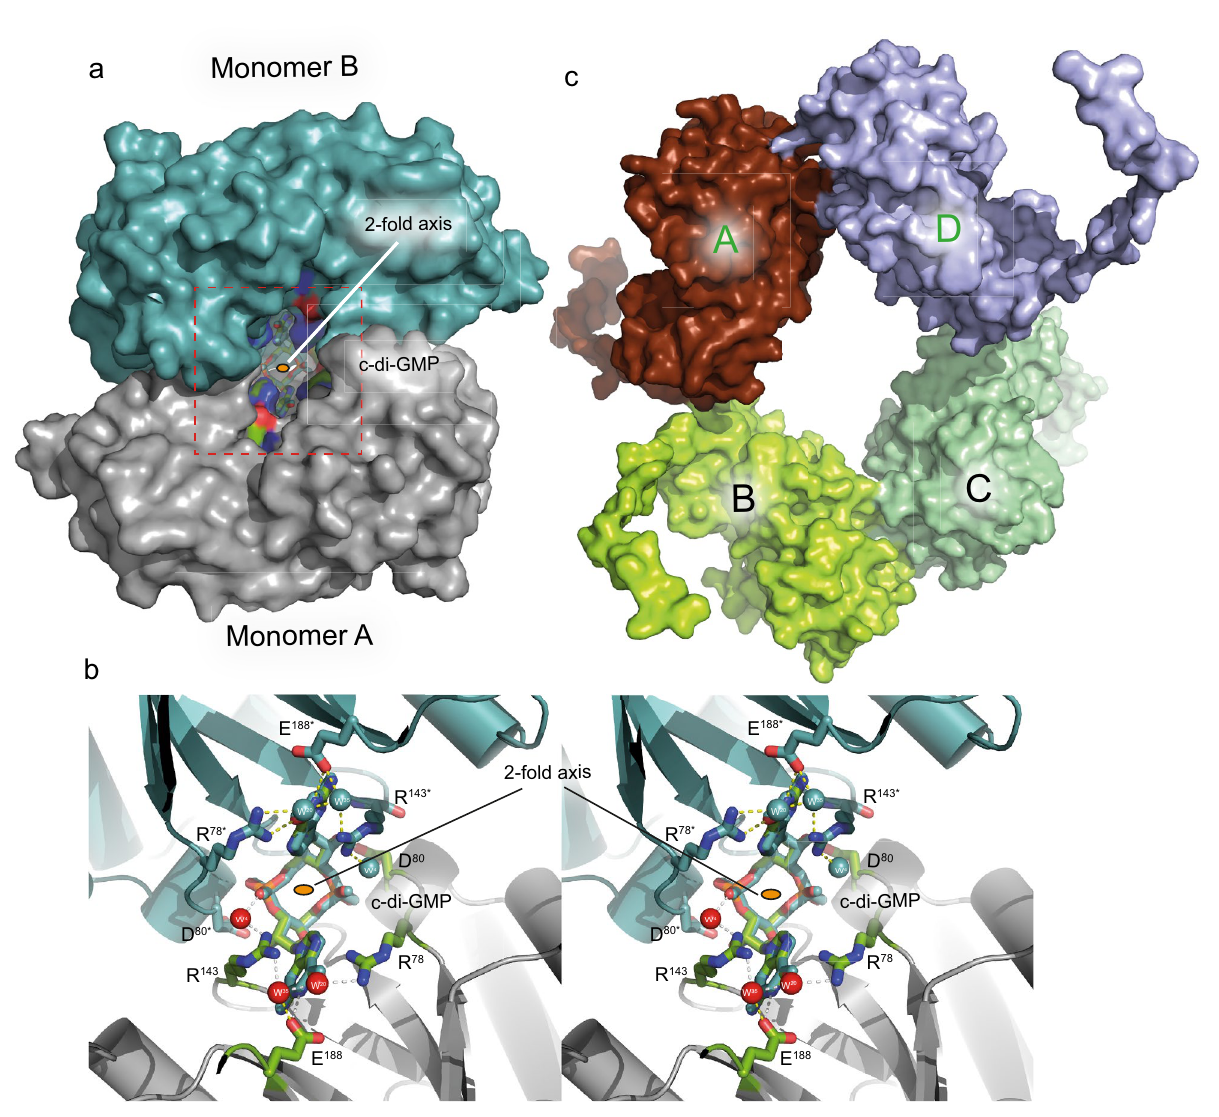
Figure 2. Crystal structures of SmbA Δloop with c-di-GMP bound across the crystallographic dyad and of apo SmbA Δloop . ( a ) The two monomers are depicted as surface (negatively charged atoms in red, positively charged atoms in blue and carbon atoms in green) with monomer A (gray) in standard orientation and monomer B (symmetry mate) in cyan. c-di-GMP in the dimer interface is shown as ball-and-stick model. ( b ) Stereoview down the twofold axis (indicated as a small orange ellipsoid), showing c-di-GMP forming isologous interactions with the two SmbA Δloop protomers. Relevant residues are shown as color-coded sticks (oxygen, red; nitrogen, blue; carbon, green or cyan and waters as red and cyan spheres) and labeled. Residues and waters of the symmetry mate monomer are marked with an asterisk. Hydrogen bonds between subunits and c-di-GMP are indicated as yellow dotted lines. ( c ) Crystal packing of apo SmbA Δloop shown in surface representation. The four molecules are arranged in an asymmetric unit form two local dimers (A and D, B and C) with 2-fold